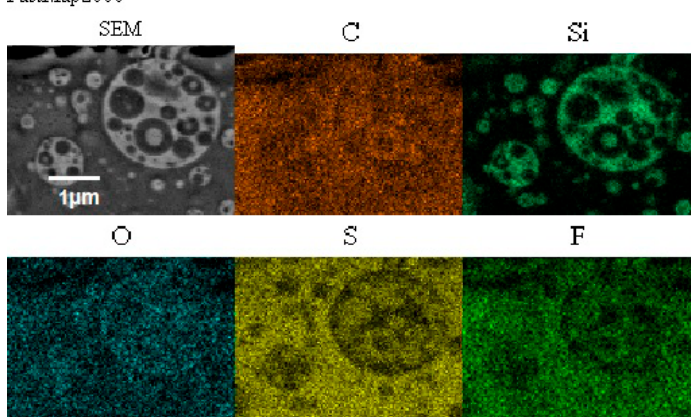
Figure 13. Distribution of elements in the composite film M prepared using reactive IL (IL 3) to dissolve prepolymer and non-reactive IL (IL 5) to dissolve lithium